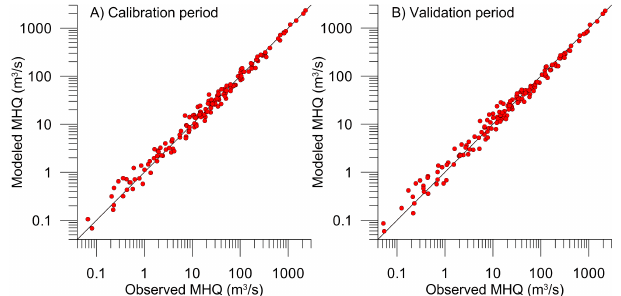
Figure 3. Observed versus predicted annual high flow from the S- HYPE model for (a) the calibration period (1999–2008) and (b) the validation period (1988–1998). MHQ = mean high